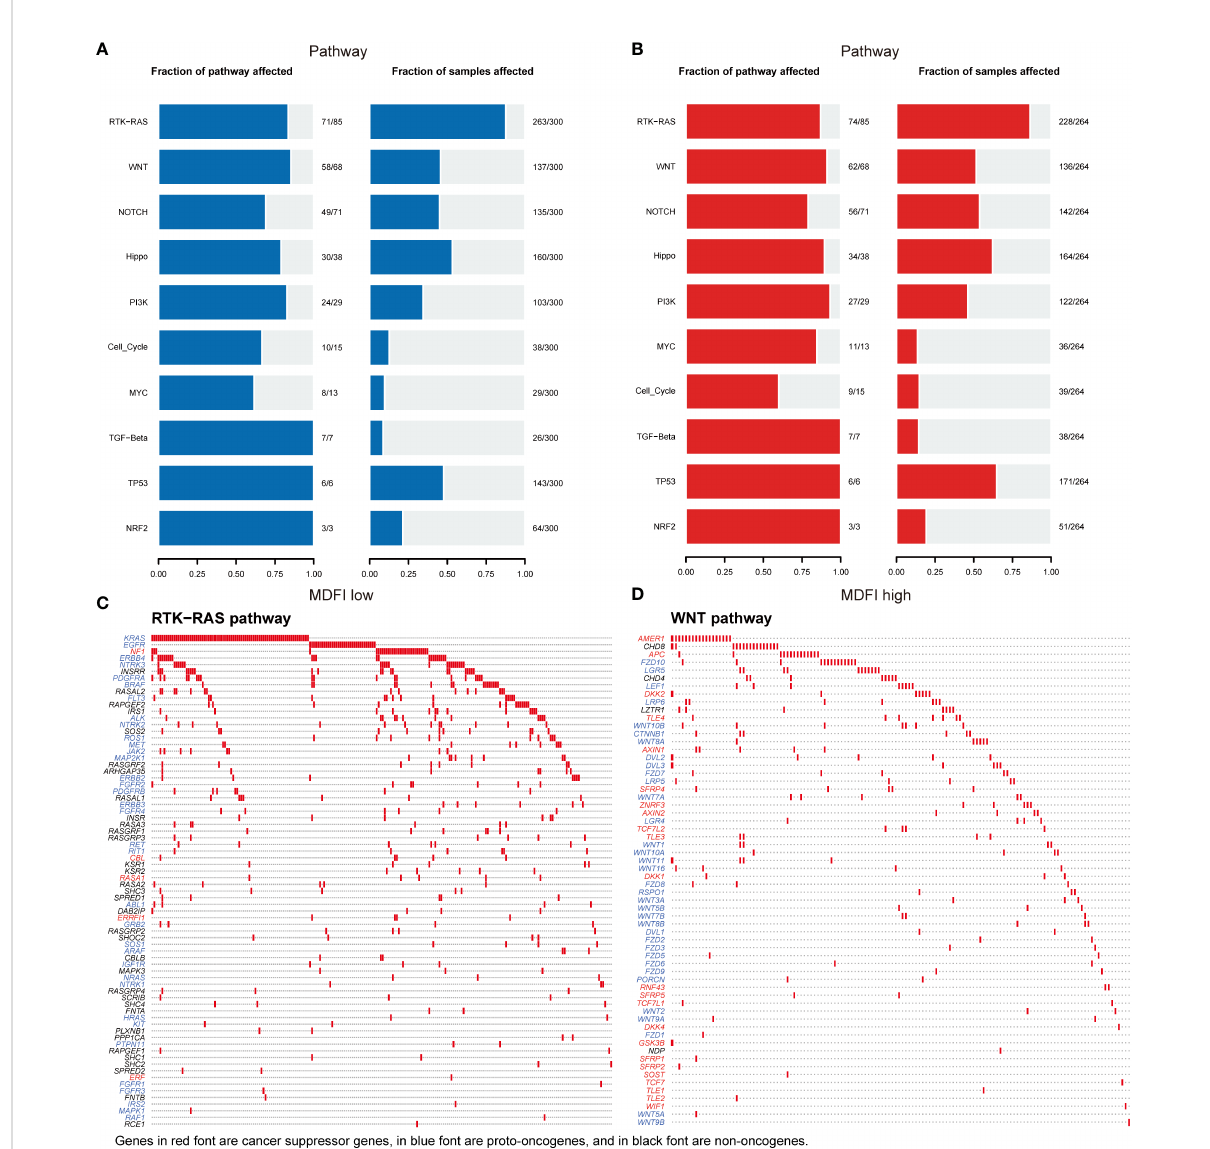
FIGURE 8 MDFI in LUAD involves mutations in the pathway data from TCGA (A) Pathway mutations of MDFI-low in LUAD, (B) Pathway mutations of MDFI- high in LUAD, (C) Mutations involved in RTK-RAS pathway, (D) Mutations involved in the WNT